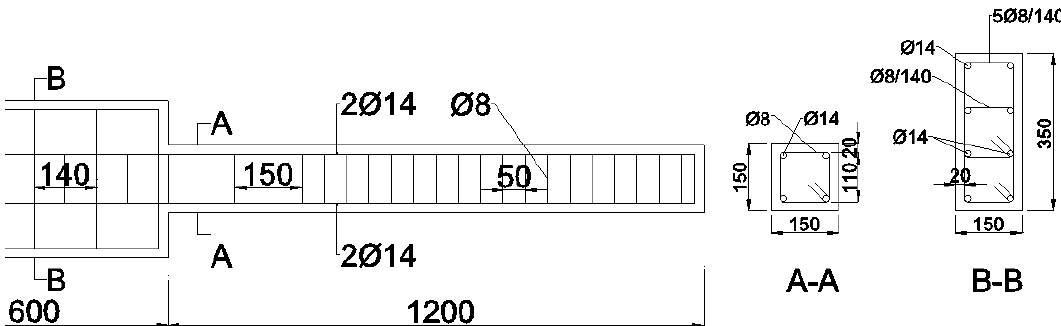
Figure 5. Reinforcement details of specimens.